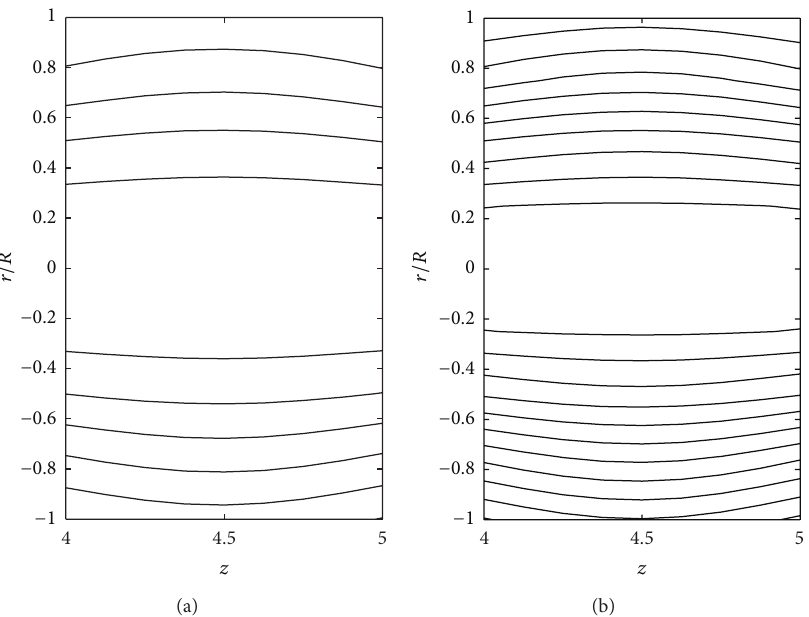
Figure 18: Stream lines for (a) power law fluid and (b) Herschel-Bulkley fluid taking 𝛿 2 = −0.2 and 𝜁 = 0.01 in the dilatation region.